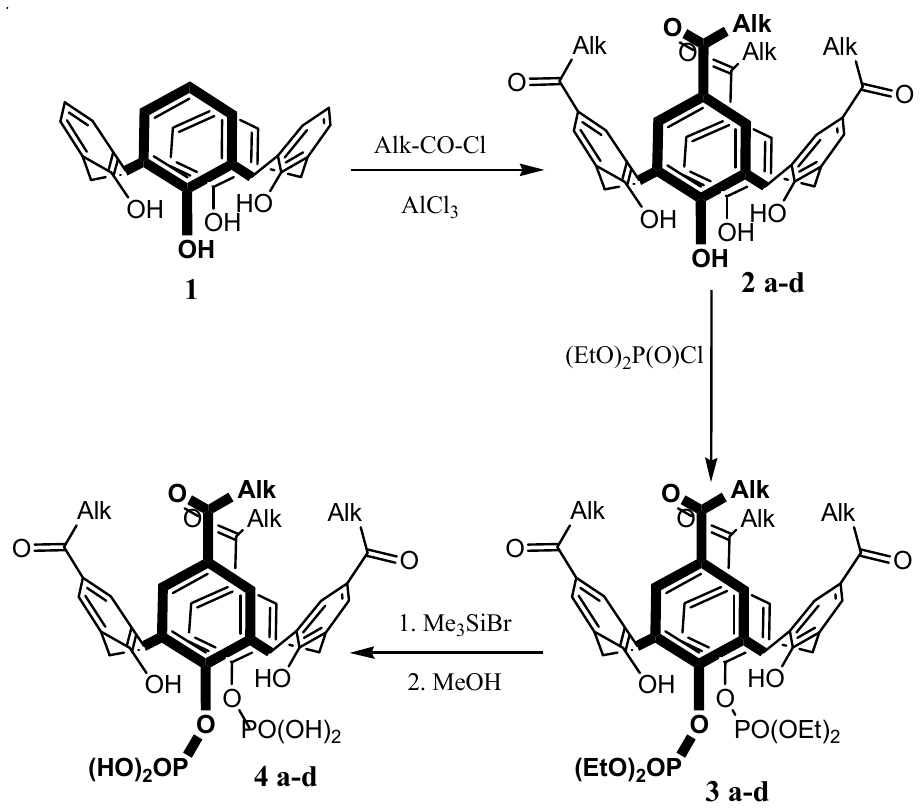
Figure 2. Synthetic route to different amphiphilic structures based on